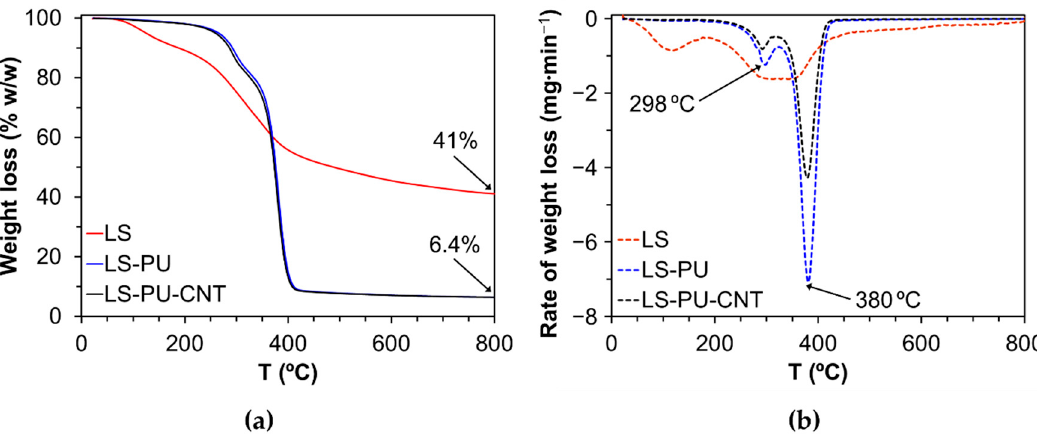
Figure 3. TGA curves of LS, LS-based PU (LS-PU), and LS-based PU doped with 1% w / w MWCNTs (LS-PU-CNT): ( a ) weight loss under inert N 2 gas flow and ( b ) derivative of the weight loss.